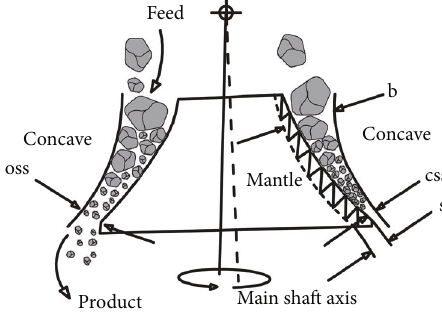
Figure 1: Jaw crusher [8].